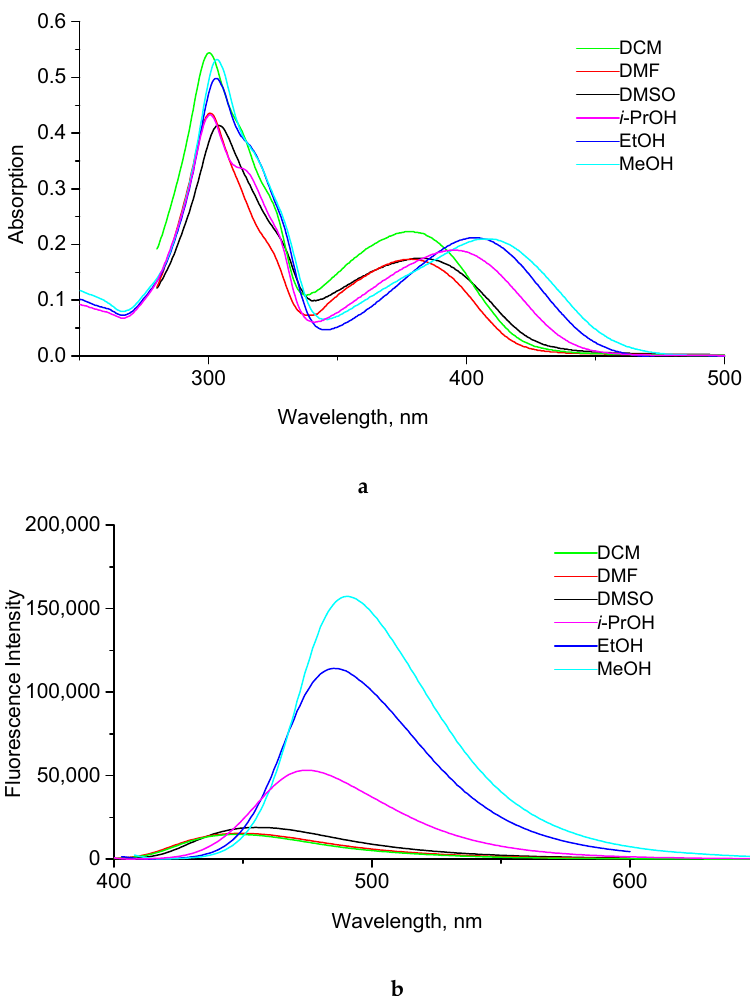
Figure 3. Absorption ( a ) and emission ( b ) spectra of compound 5a in various solvents (C = 1.0 × 10 − 5 M).